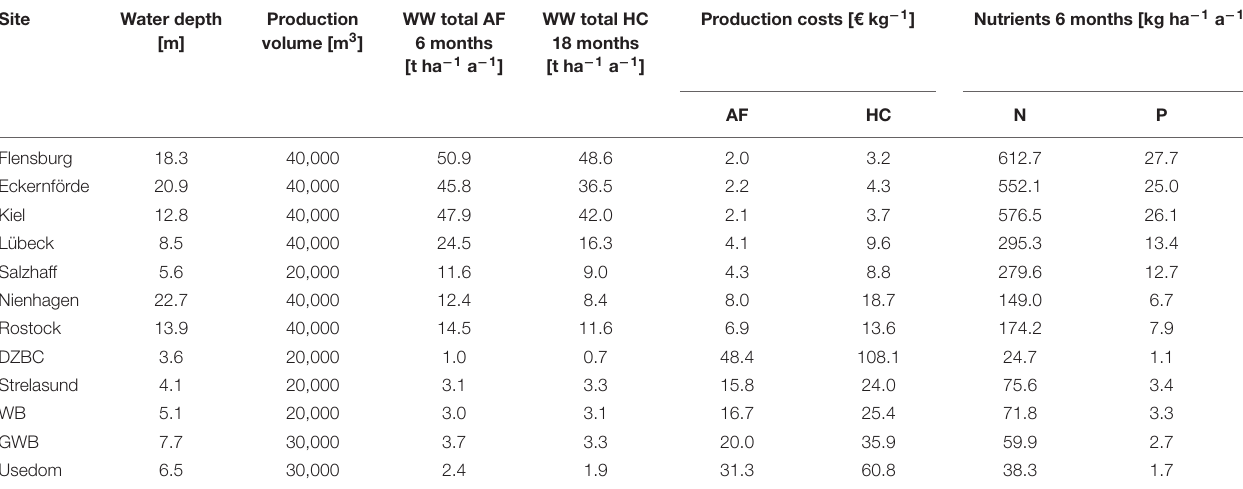
FIGURE 4 | Modeled shell growth of mussels at twelve stations along the German Baltic coast covering salinities from 7 to 17 psu ( Figure 1 ). TABLE 5 | Potential yearly mussel harvest (total wet weight, WW) for animal feed (AF) and human consumption (HC) for an established 1 ha farm, production costs for each (without upfront investment costs), as well as yearly nutrient removal [kg ha − 1 a − 1 ] if harvested as animal feed mussels. Production volumes result from water depth and applicable collector length (2, 3, or 4